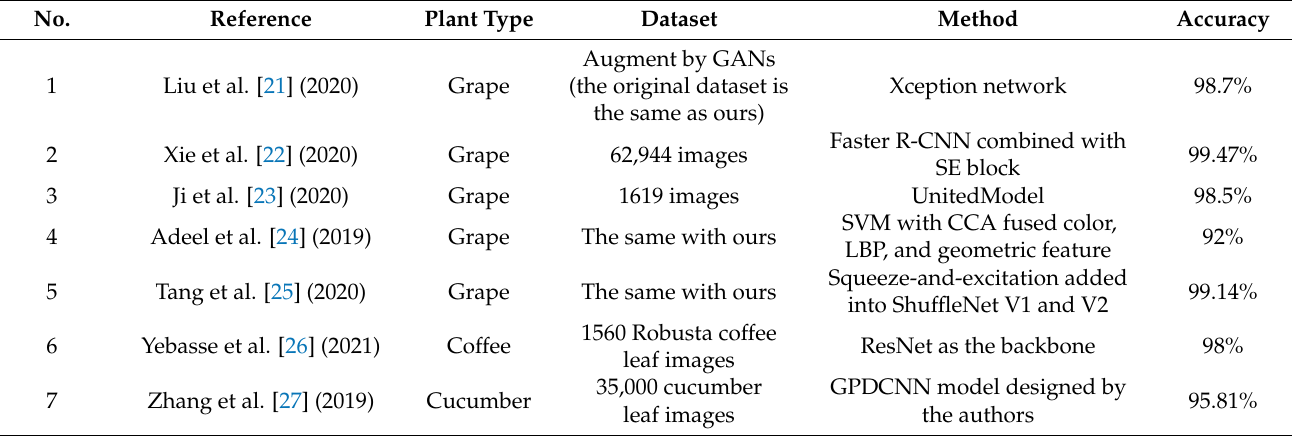
Table 11. Some other studies on plant leaf disease